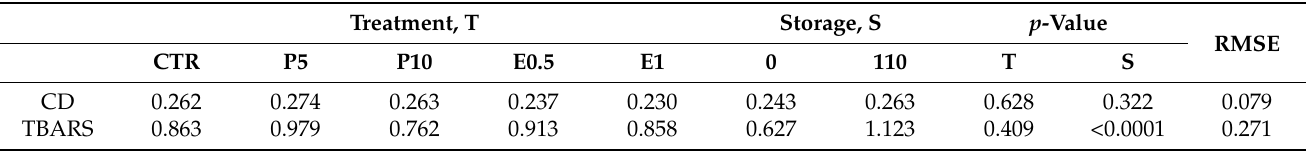
Table 5. Conjugated dienes (CD, mmol Hp/100 g fillet), and TBARS content (mg MDA-eq./kg fillet) determined on fillets from gilthead seabream fed the different dietary treatments analyzed before (day 0) and after 110 days of frozen